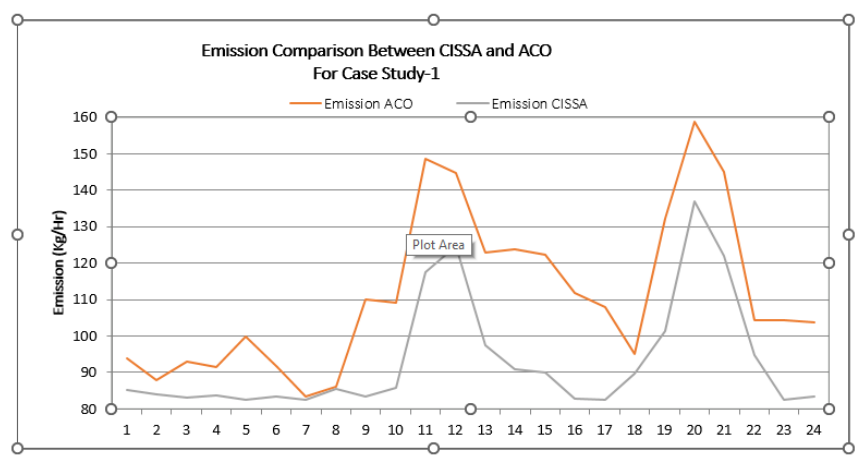
Figure 6. Fuel-cost comparison between CISSA and ACO.